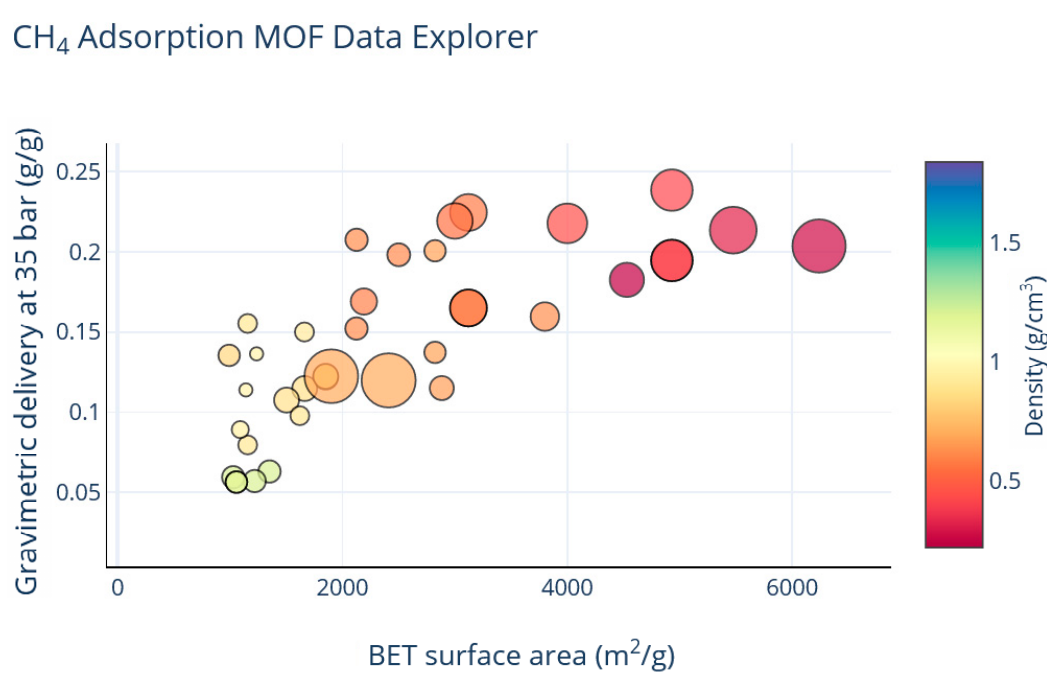
Figure 7. QSPR for CH 4 storage in MOFs. CH 4 gravimetric deliverable capacity at 298 K and 35 bar against BET surface area. Each point represents a MOF. The data points are color-coded for MOF density, and the diameter of each circle represents the largest cavity diameter (LCD) of each MOF.